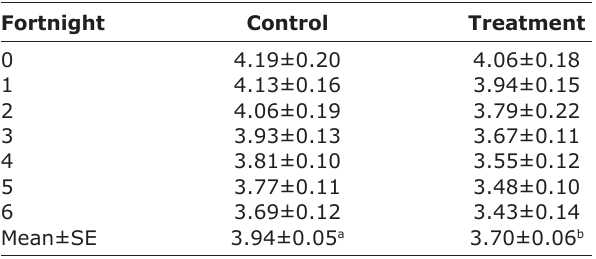
Table-7: Fortnightly cortisol concentration (ng/ml) in KF Heifers. Fortnight